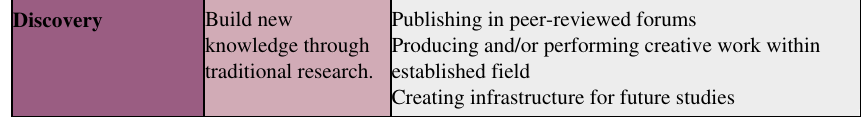
Figure 1. Discovery ‘type’ of Boyer’s Model of